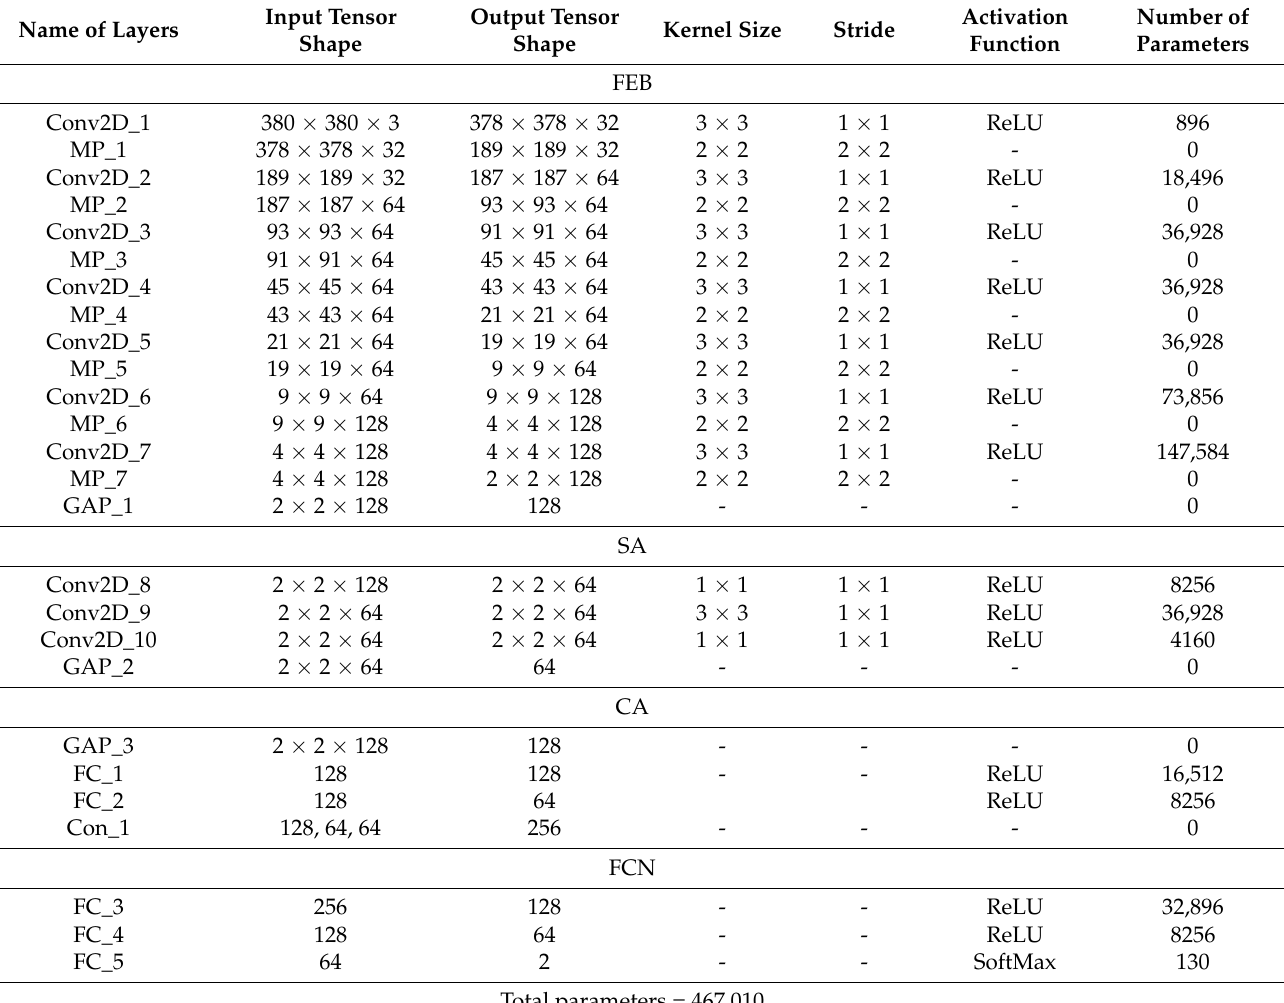
Table 1. Detailed configuration specifications of our proposed model.